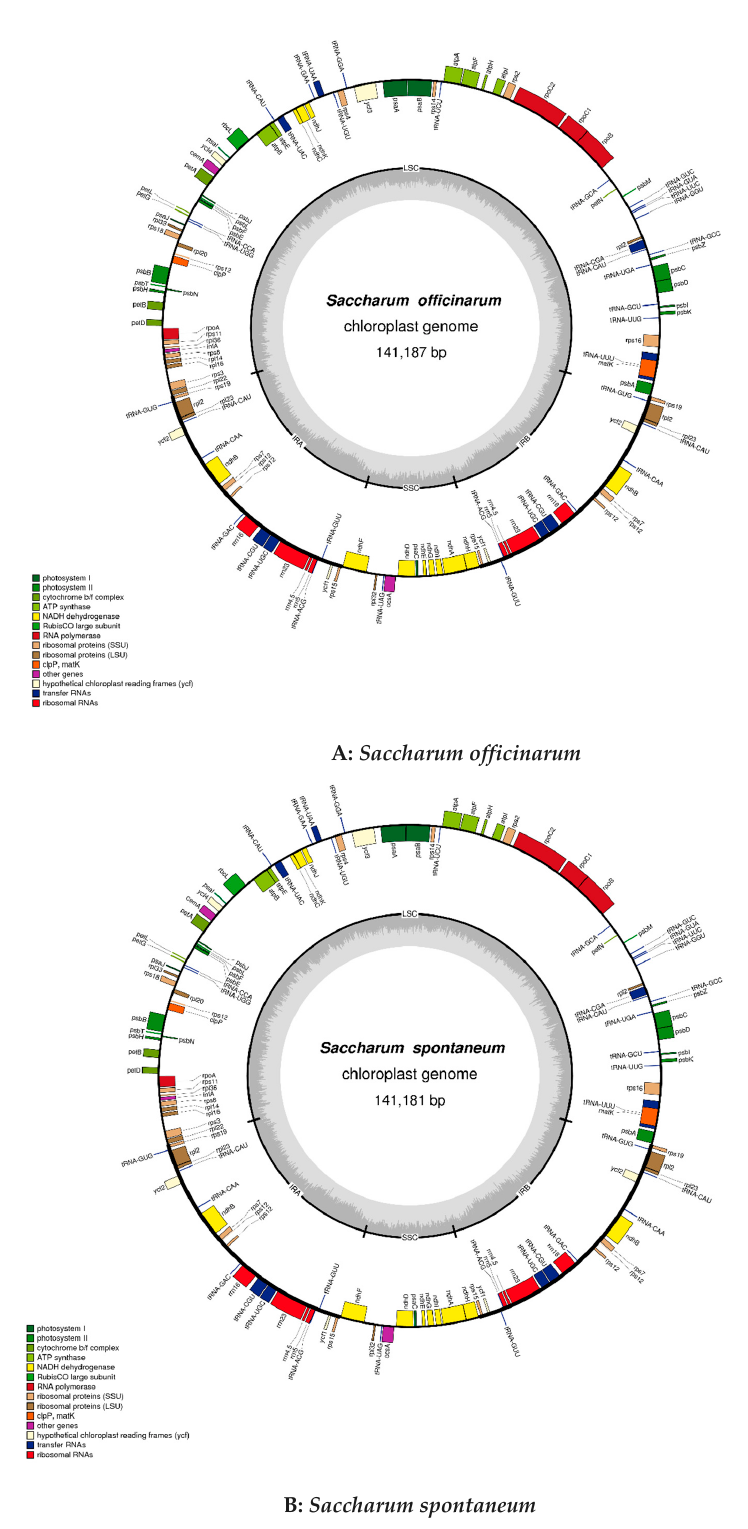
Figure 2. Gene maps of the complete chloroplast genome of Saccharum officinarum ( A ) and S. spontaneum ( B ) generated by software OGDRAW. As indicated in Figure 2, genes located outside of the outer circle are transcribed in the counterclockwise direction, while those located inside are transcribed in the clockwise direction. Different functional gene groups are represented in color codes. In addition, the variations of GC and AT content are indicated by lighter gray and darker gray plot in the inner circle, respectively. Table 1 . Gene contents in the chloroplast genomes of Saccharum officinarum and S. spontaneum . Functions